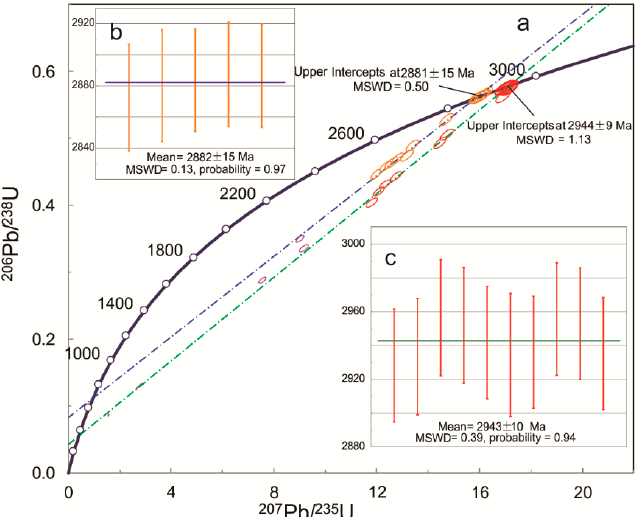
Figure 11. Zircon U–Pb concordia age diagrams for the granite dike (D0002-4). ( a ) Diagram for all analyzed spots that gave two discordia lines with upper intercept 207 Pb / 206 Pb ages of 2994 ± 9 Ma and 2881 ± 15 Ma; ( b ) Diagram for five concordant analyses that gave a weighted mean 207 Pb / 206 Pb age of 2882 ± 15 Ma; ( c ) Diagram for 10 concordant analyses that gave a weighted mean 207 Pb / 206 Pb age of 2943 ± 10 Ma.